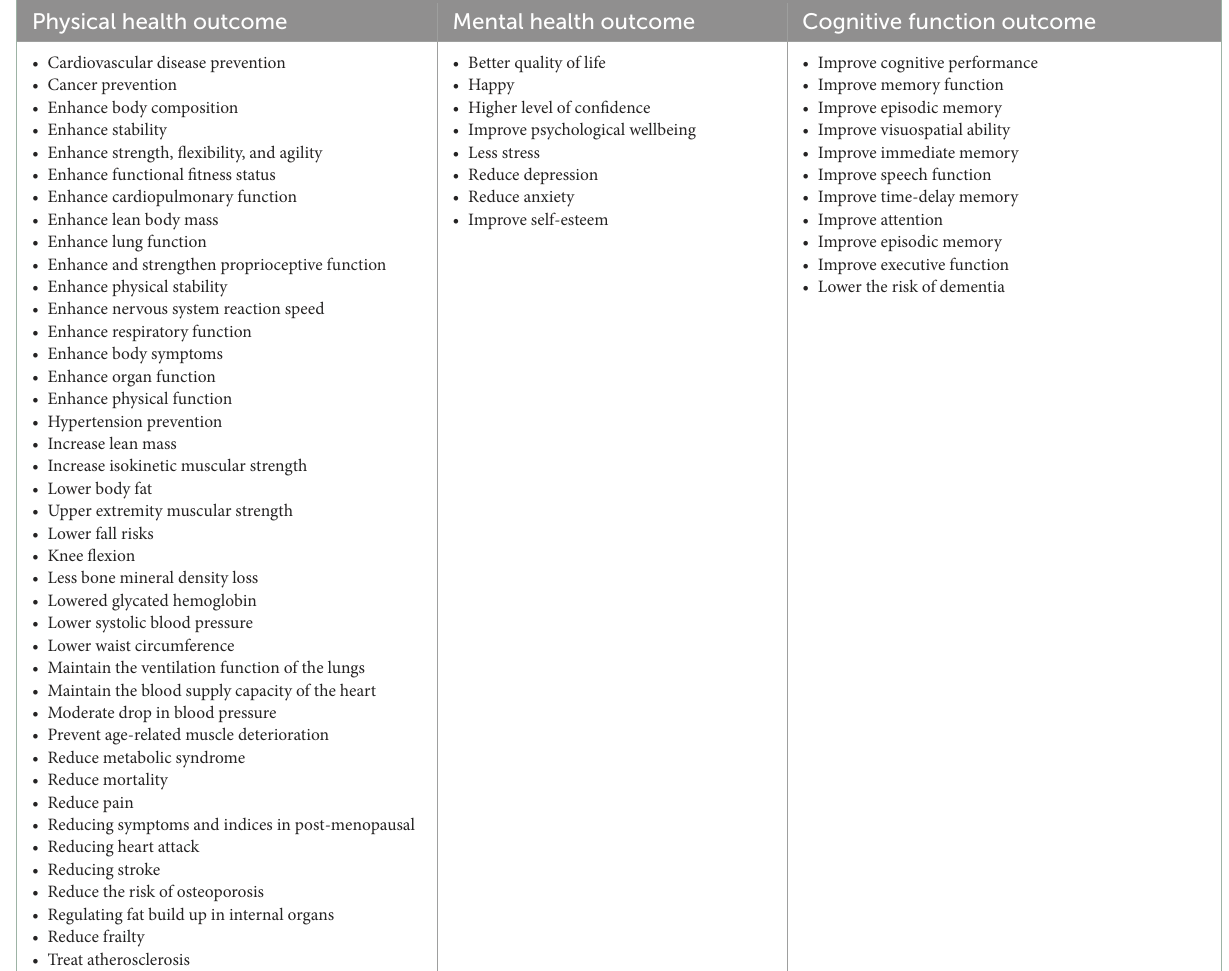
TABLE 1 The relationship between physical activity and mental and cognitive health-related outcomes. Physical health